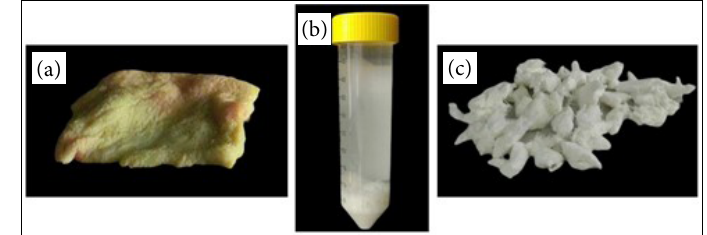
Figure 1 - Porcine skin decellularization. (a) Porcine skin in natura . (b) Porcine skin triturated and incubated with reagents (trisol) during the decellularization process. (c) Decellularized and lyophilized extracellular matrix (n = 5).